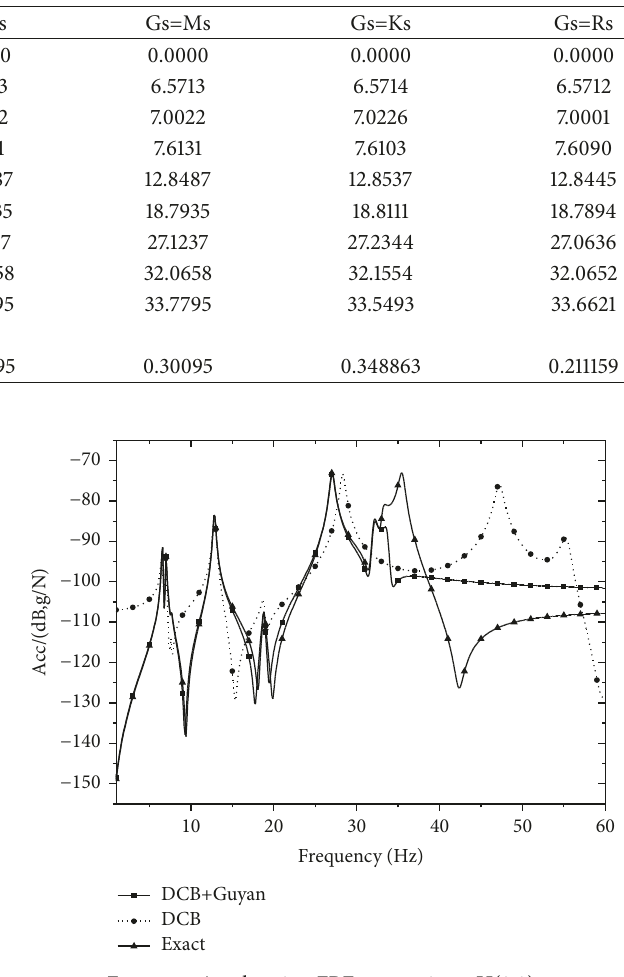
Figure 5: Acceleration FRF comparison,